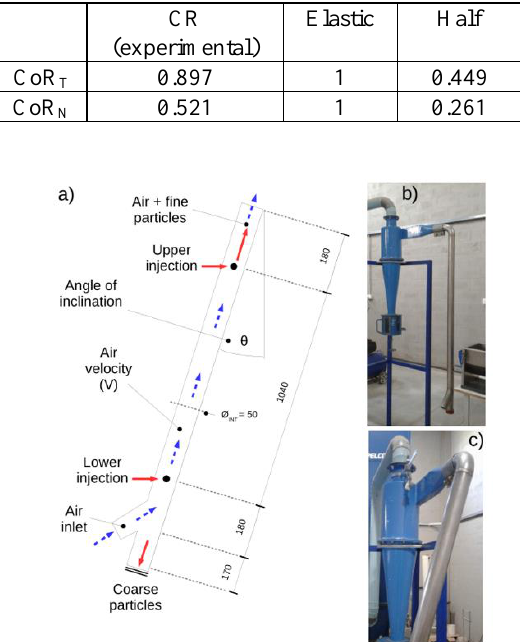
Fig. 1 . Layout of the geometry of the tube-shaped classifier. a)